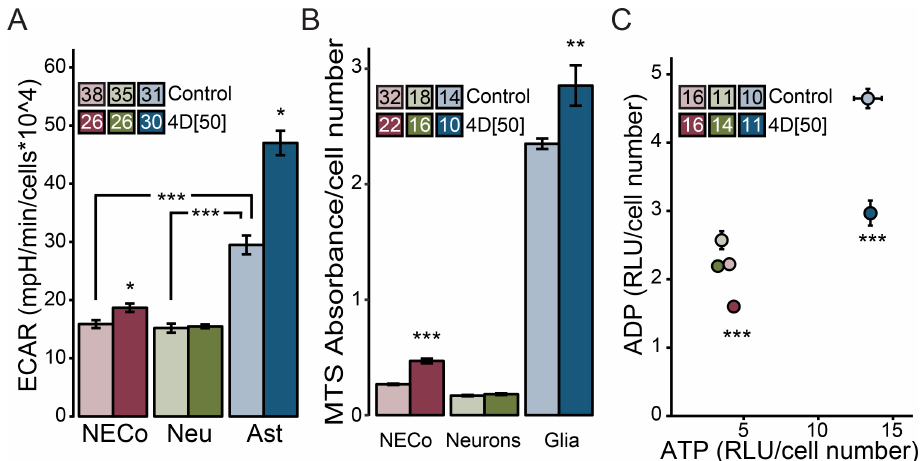
Fig 5. Impaired mitochondrial respiration increasesastrocytic, but not neuronal, rate of glycolysis. (A) Basal extracellular acidificationrate (ECAR) of NECos, neurons, and astrocytes, in the presence and absenceof EtBr. (B) Relativequantity of electron donors (i.e. NAD(P)H, FADH 2 ) across culture conditions, measuredby MTS absorbance and normalized to cell number. (C) RelativeADP plotted against relativeATP. Arrows show the directionof changefrom control to EtBr treatment for each culture condition. RLU, relative luminescence units. Error bars reflect +/-SEM. N for each group is includedin figure legends. (A) *** = p < 0.001; * = p < 0.05, followingDunn’spost-hoc test. (B), (C) *** = p < 0.001, ** = p < 0.01 comparedto respectivecontrols.